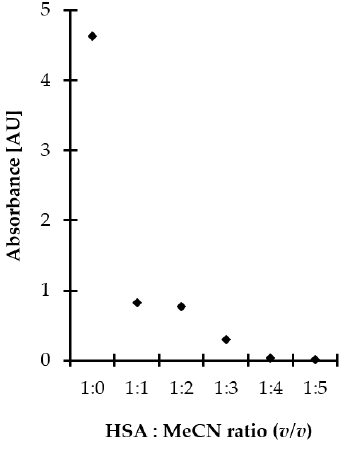
Figure 2. Influence of MeCN amount on deproteinization efficiency, expressed as signal intensity of HSA. Samples were analyzed using the spectrophotometric method based on measurements of the absorption of water–MeCN supernatants of samples at 280 nm.